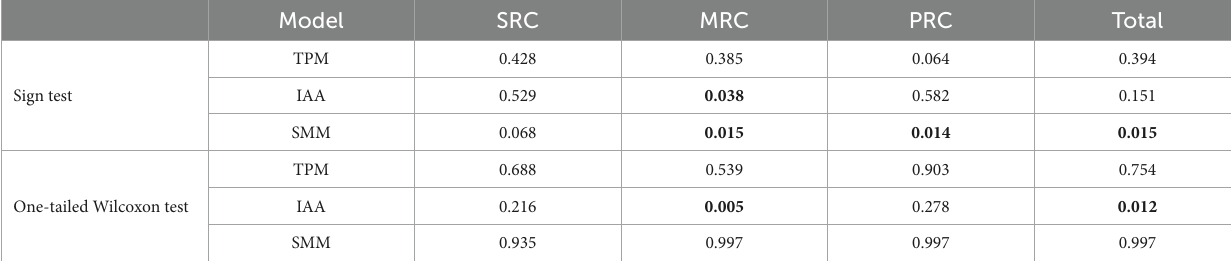
TABLE 3 The probability of population bottlenecks of the three phenotypic groups varying in cold resistance and the entire population based on 10 nuclear microsatellite loci under the three